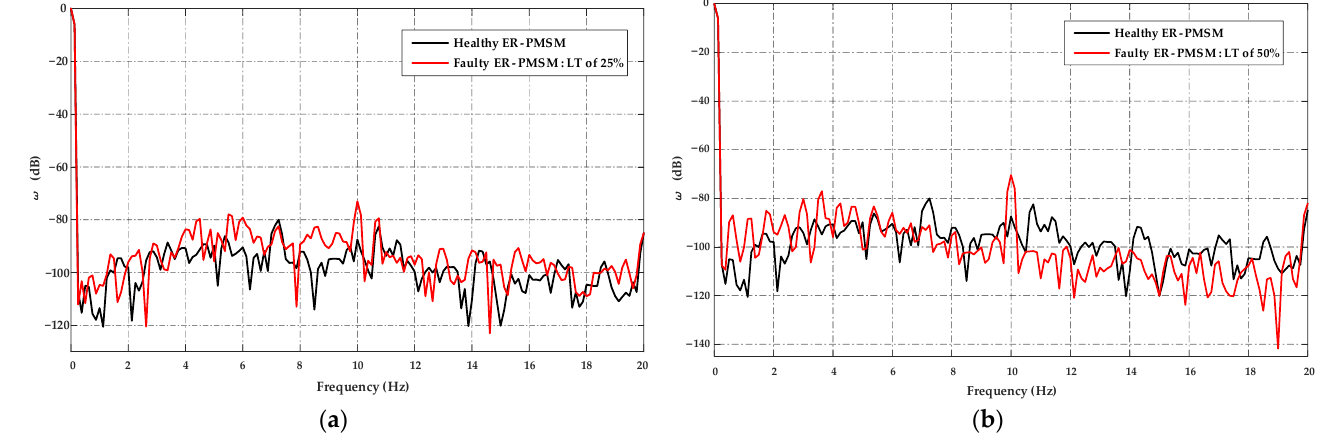
Figure 19. Experimental speed spectrum of the ER-PMSM at 8 Nm load and 600 rpm, in healthy and faulty conditions. ( a ) LTs fault of 25%; ( b ) LTs fault of 50%.